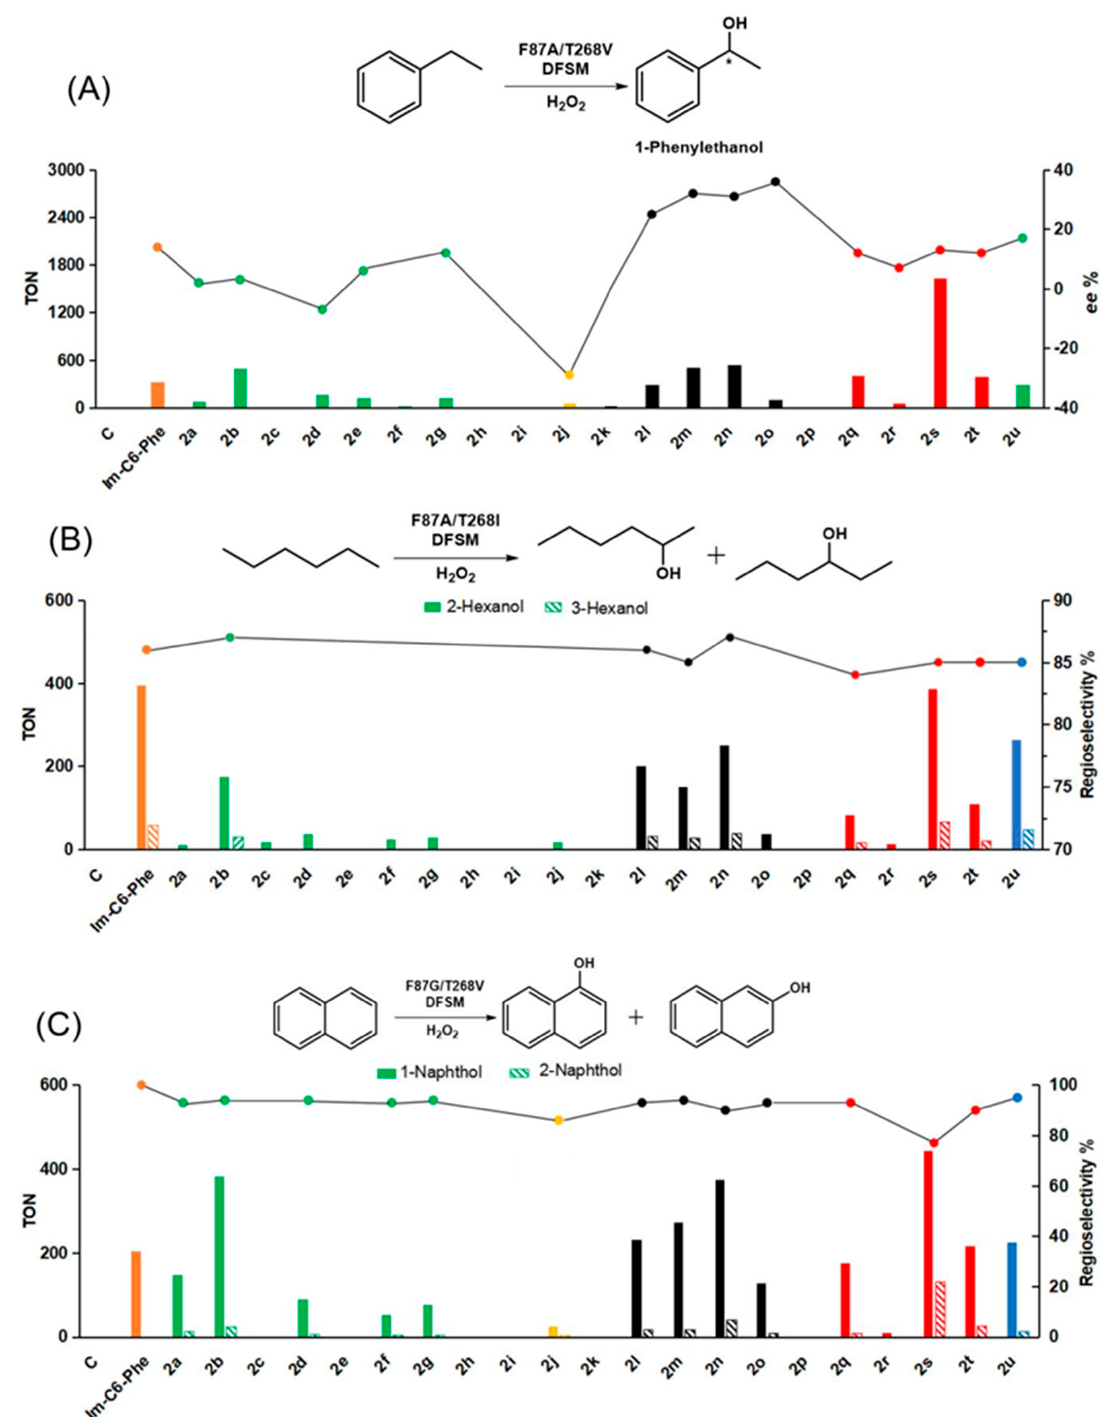
Figure 3. H 2 O 2 -dependent hydroxylations of ethylbenzene ( A ), hexane ( B ), and naphthalene ( C ) catalyzed by P450BM3 in the absence/presence of DFSMs. ee , enantiomeric excess (%) of ( R )-(+)-1- phenylethanol determined by chiral GC and was calculated by (( R )-(+)-1-phenylethanol − ( S )-(-)-1- phenylethanol)/(( R )-(+)-1-phenylethanol + ( S )-(-)-1-phenylethanol) according to the corresponding peak area. Regioselectivity was determined according to the corresponding TON, for hexane hydroxylation: 2-hexanol/(2-hexanol + 3-hexanol), and for naphthalene hydroxylation: 1- naphthol/(1-naphthol + 2-naphthol). The TON and ee % values are presented as bar and stacked line charts, respectively. *: The chiral carbon atom.